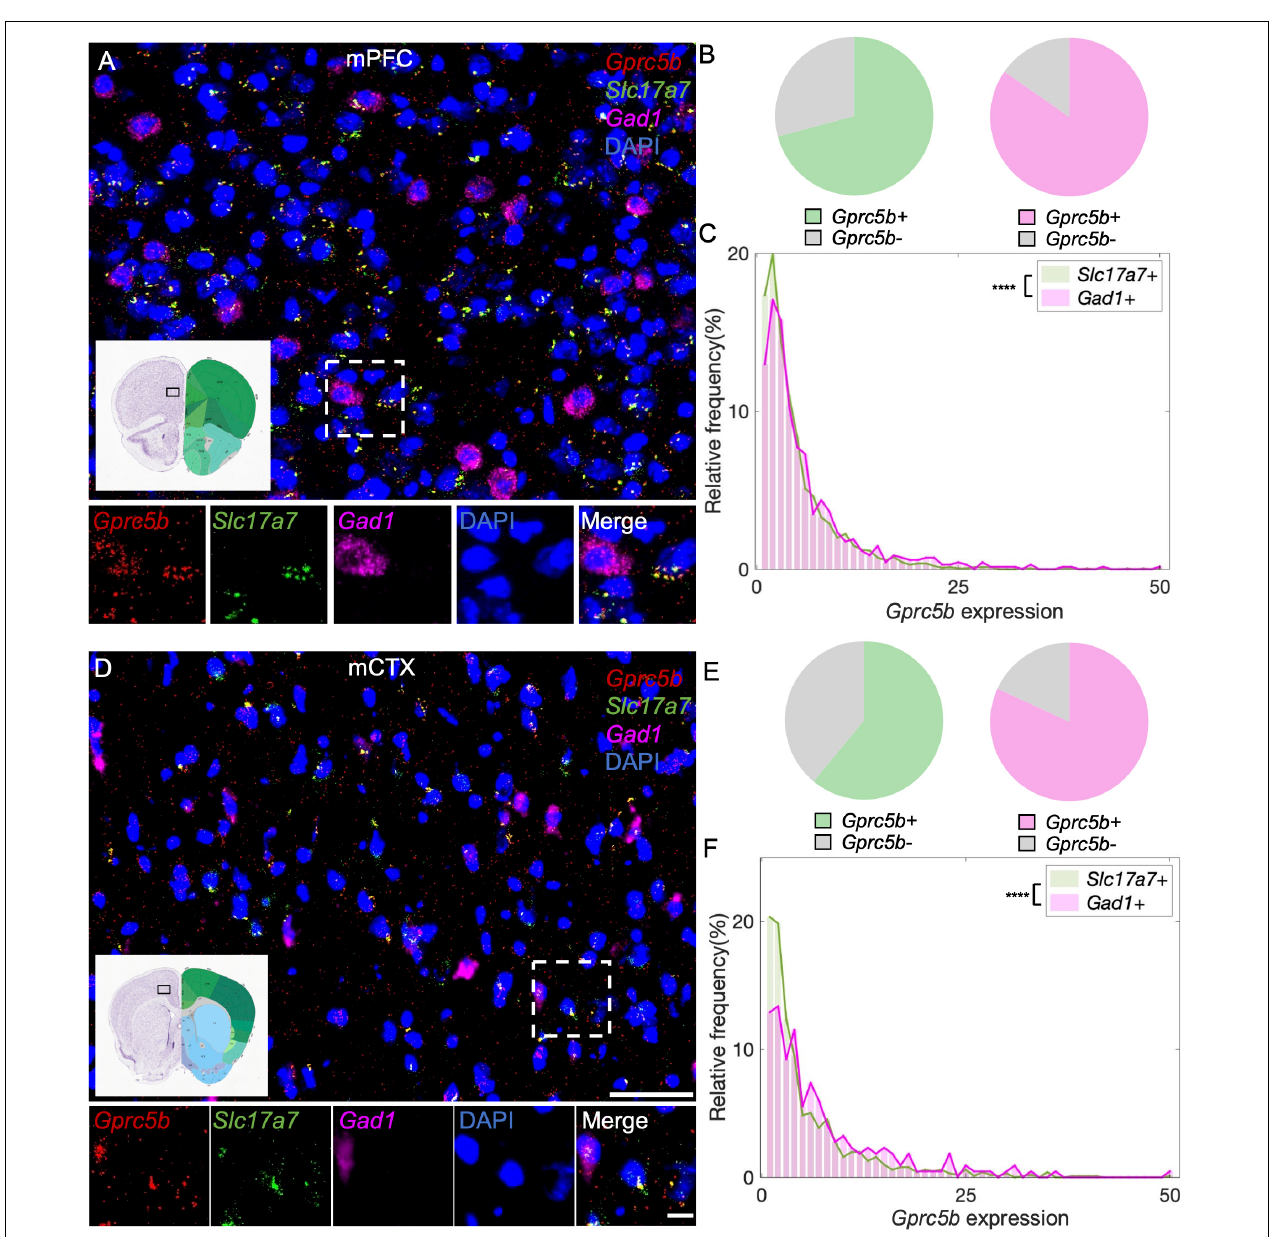
FIGURE 6 | Distribution of Gprc5b mRNA within glutamatergic and GABAergic neurons in cortical regions. Representative in situ hybridization images indicating Gprc5b mRNA distribution in mPFC (A) and in mCTX (D) . Gprc5b was stained in red, Slc17a7 as a marker for glutamatergic neurons in green, gad1 as a marker for GABAergic neurons in magenta, and DAPI for nuclei in blue. Pie charts indicating percentage of Gprc5b positive neurons in mPFC (B) and mCTX (E) where Gprc5b positive glutamatergic neurons are indicated in green while Gprc5b positive GABAergic neurons are in magenta. (C) Frequency distribution analysis indicating Gprc5b mRNA expression in mPFC within glutamatergic and GABAergic neuronal populations (Bin width = 1, sampled from 2462 glutamatergic neurons and 686 GABAergic neurons of 2–4 animals, p < 0.0001 from two-sided Wilcoxon–Rank sum test). (F) Frequency distribution analysis of Gprc5b mRNA expression in mCTX within glutamatergic and GABAergic neurons (Bin width = 1, sampled from 1013 glutamatergic neurons and 217 GABAergic neurons of 2–4 animals, p < 0.0001 from two-sided Wilcoxon–Rank sum test). Scale bar: 50 µ m; scale bar of magnified images: 10 µ m; reference brain images are from Allen brain atlas. **** p <